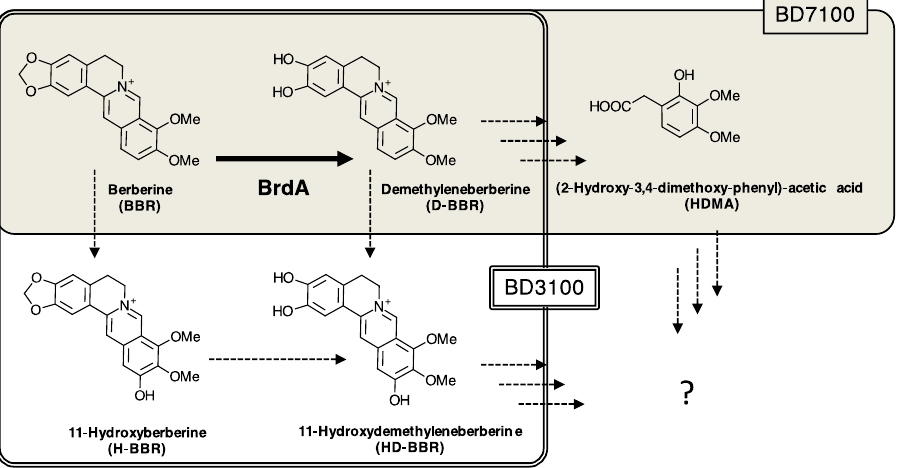
Figure 1. The BBR metabolites and deduced degradation pathway in BD3100 and BD7100. The BBR metabolites identified in BD7100 and BD3100 are boxed by a double line (with a filled background) and a single line, respectively. The thick arrow indicates demethylenation at the 2,3-methylenedioxy ring of BBR, which was a focus of this study. The dotted arrows indicate the deduced degradation